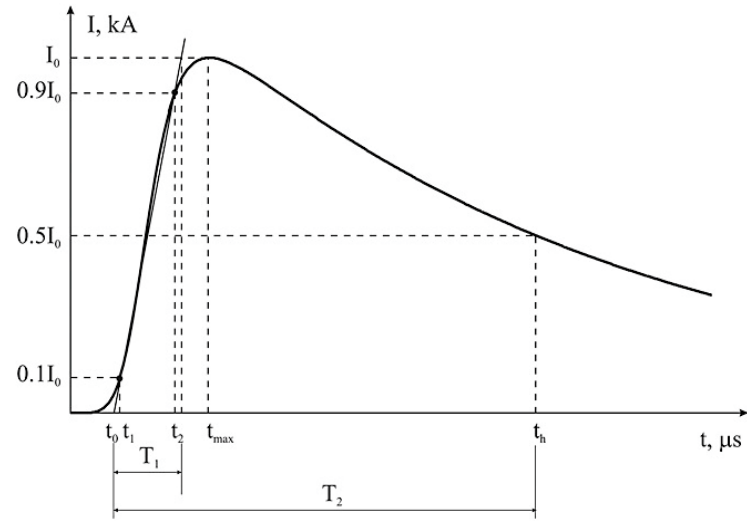
Figure 9. Lightning current approximation by the Heidler function.